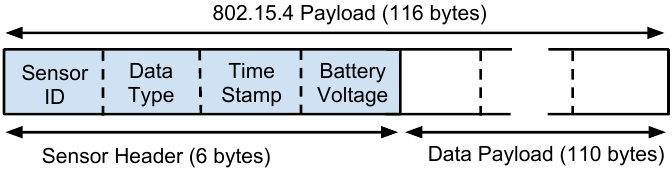
Figure 2. Message structure for Unmanned Aerial Vehicle (UAV)-to-WSN